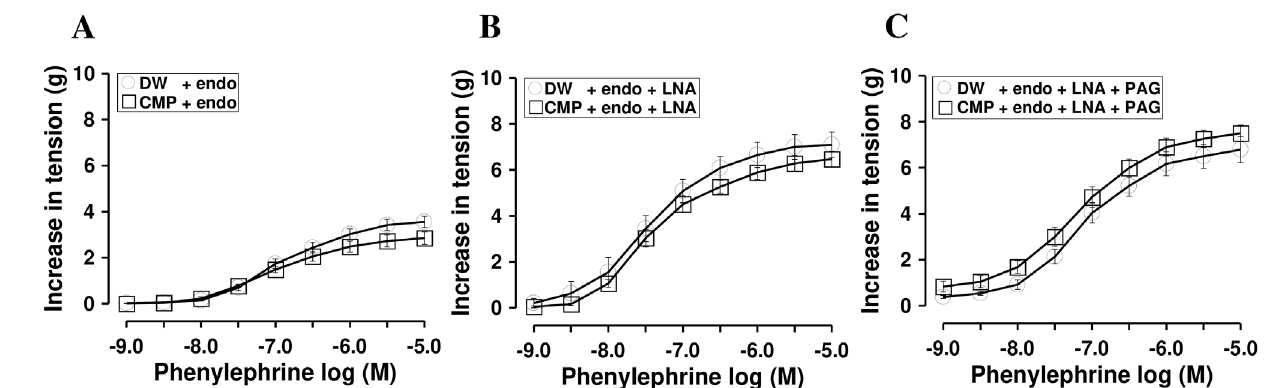
FIGURE 5 - Effects of CMP (1 g/kg) or distilled water (DW, control) consumption by the middle-aged male rats on contractile response to phenylephrine of endothelium-intact (endo, A), endothelium-intact with L-NA (B), endothelium-intact in the present of L-NA and PAG thoracic aorta (C). Values represent mean ± SEM; n =